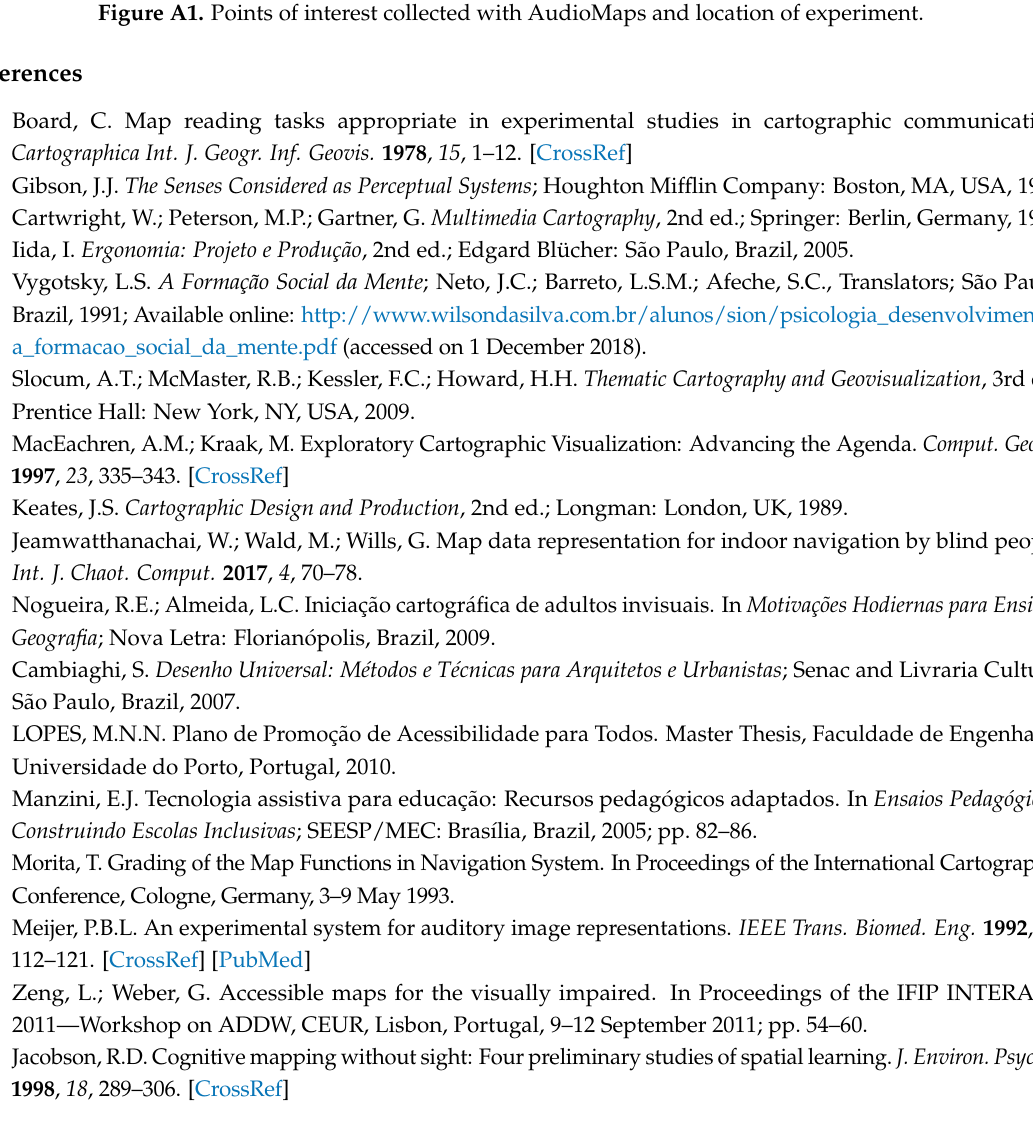
Figure A1. Points of interest collected with AudioMaps and location of experiment.